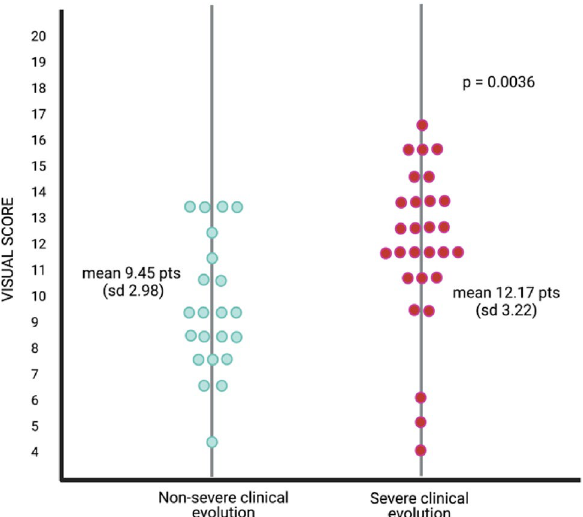
Figure 1. Silhouette plots for the analysis of the two different clusters associated to clinical evolution in our cohort against VISUAL score. Patients with non-severe clinical evolution presented a mean of 9.45 points (SD 2.98) and patients with severe clinical evolution (Cluster B) with a mean of 12.17 points (SD 3.22) (p = 0.0036). Created with